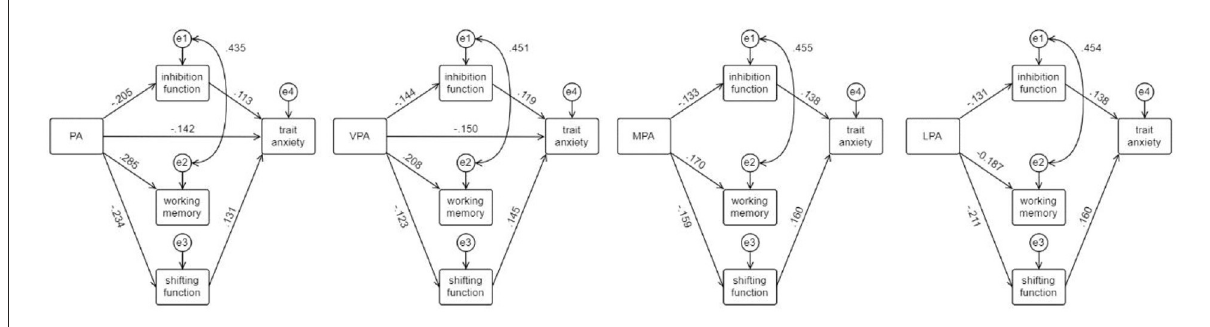
FIGURE7 Schematic diagram of the pathway analysis of physical activity level affecting trait anxiety through executive function.